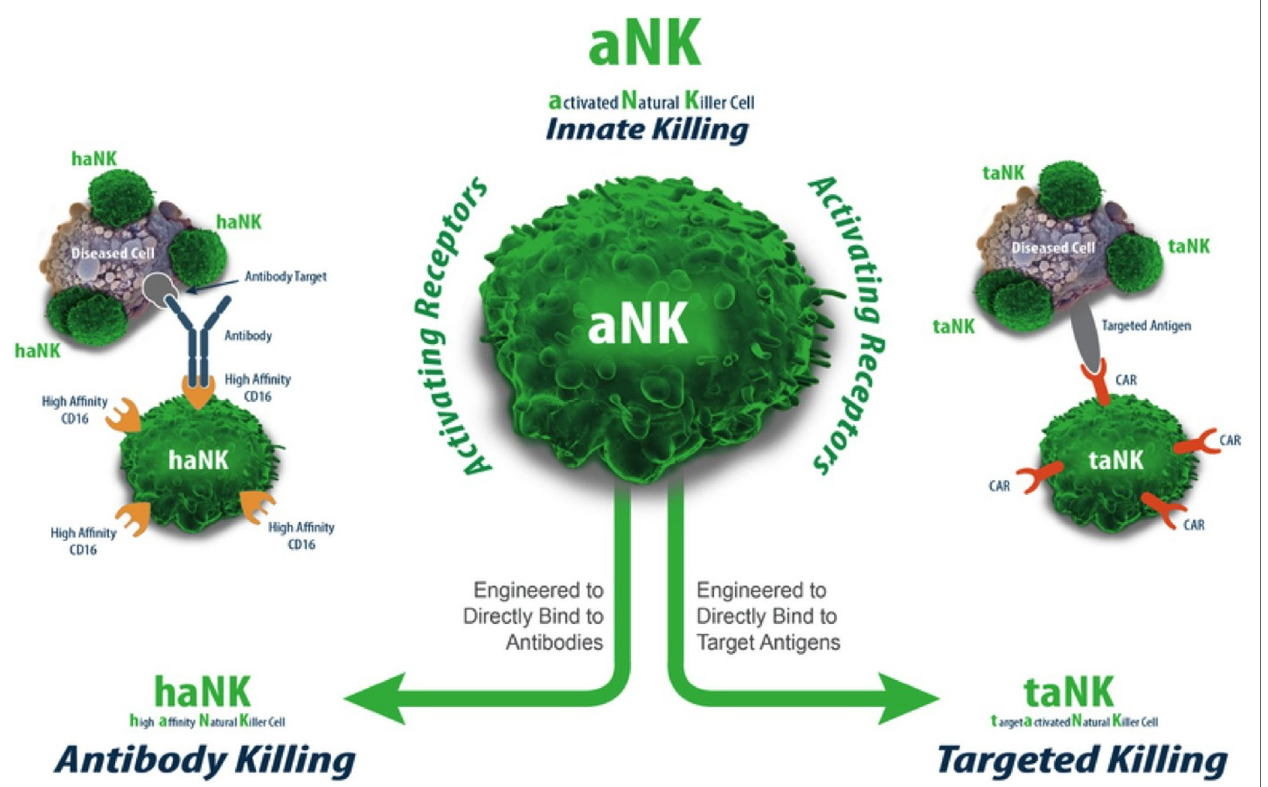
FiGURe 2 | aNK, haNK, and taNK